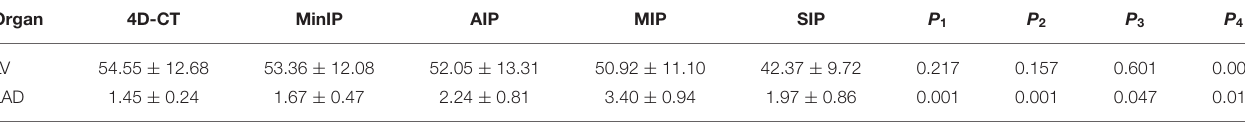
TABLE 1 | Volume changes in the LV and LAD ( x ± s) cm 3 .